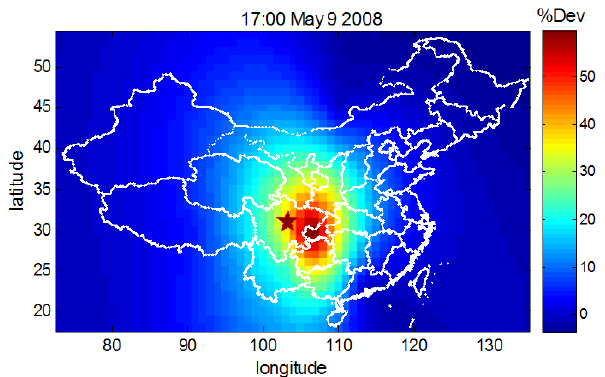
Fig. 3. Two-dimensional map of %Dev at 17:00LT where and the red star denotes the epicenter (Xu et al., 2010a).